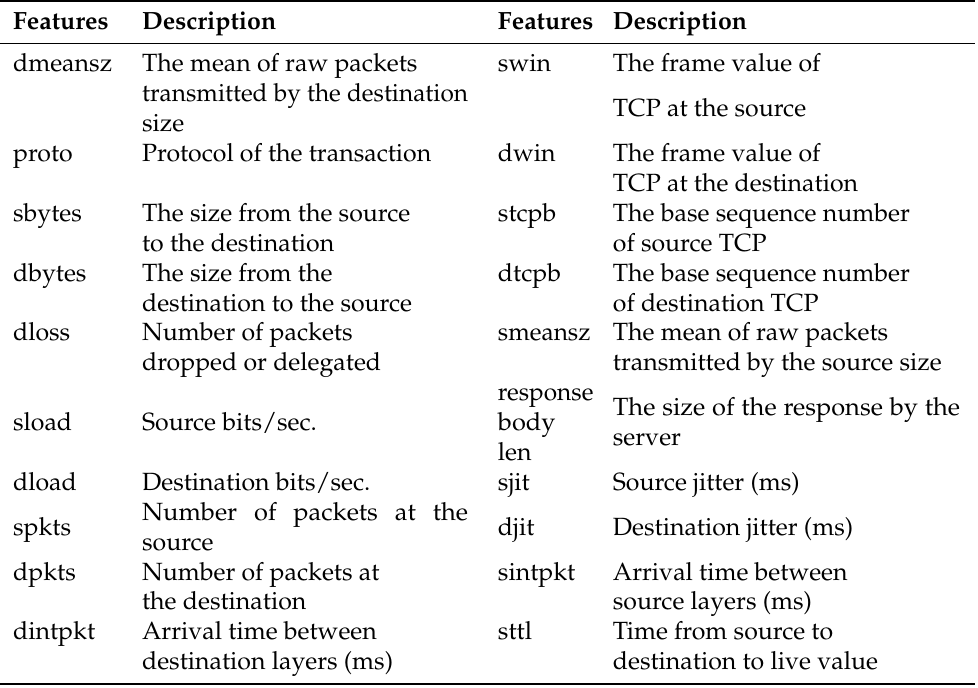
Table 3. Description of the top 20 selected